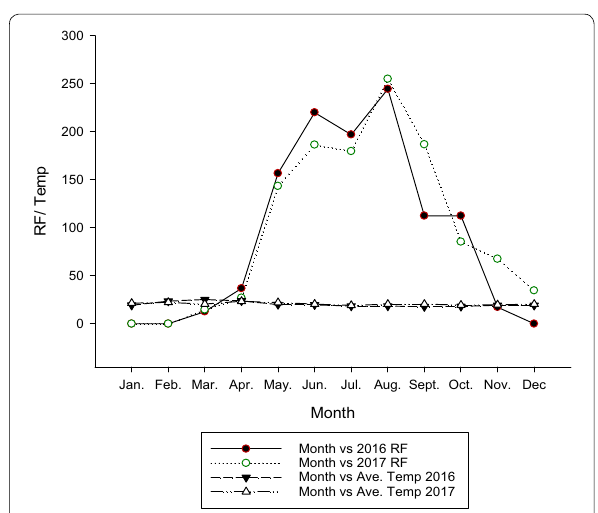
Fig. 1 Rainfall and average temperature for 2016/17 and 2017/2018 seasons of Assosa site (climate data for Begi is not